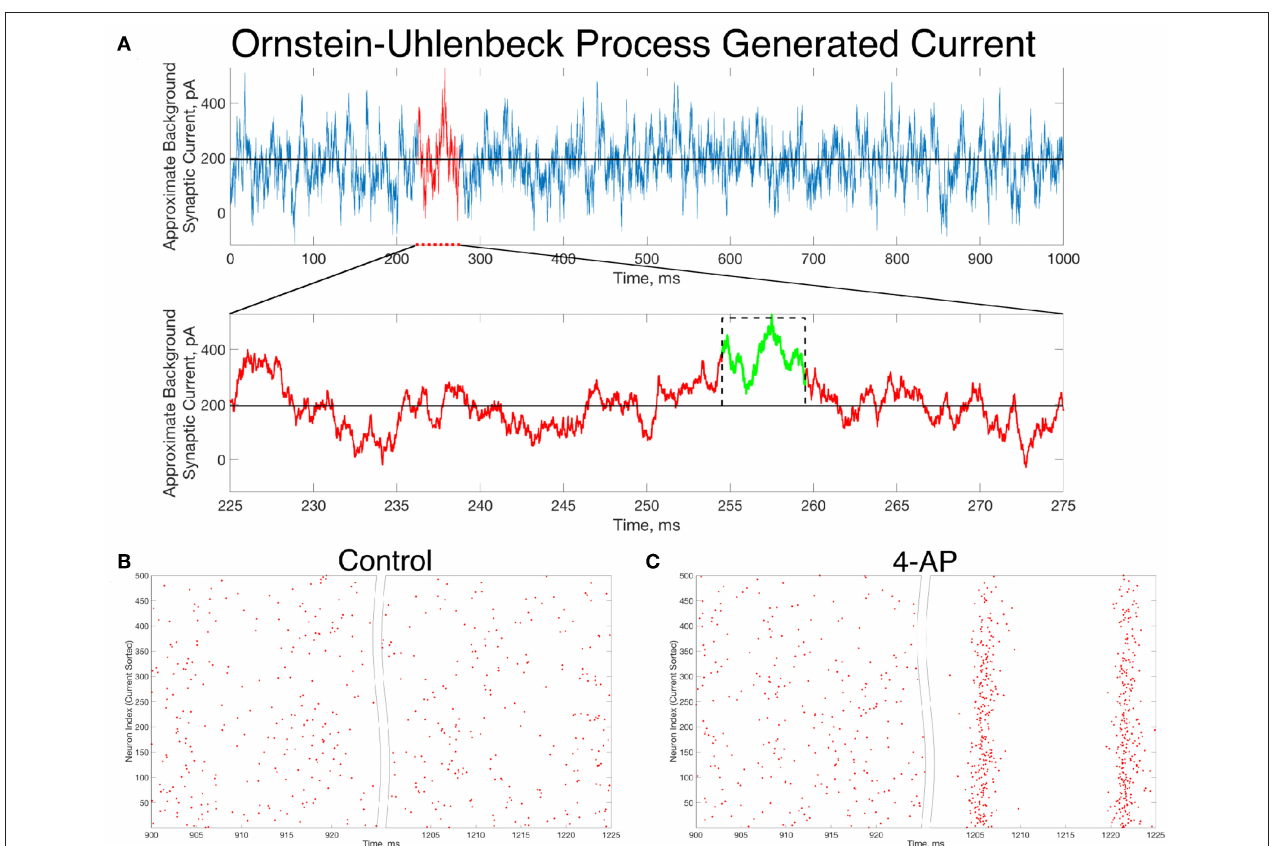
FIGURE 6 | In vivo -like excitatory background synaptic currents can also elicit “bistable transitions” in the model inhibitory networks. (A) An example of excitatory background synaptic current (1,000 ms in the top panel) generated using an Ornstein-Uhlenbeck Process with parameters informed by cortical experimental literature. The bottom panel zooms in on a region of interest (plotted in red) revealing a brief period (plotted in green) in which the current is significantly larger than its average value, activity which has perturbation-like qualities. This activity is approximated by a current pulse of similar width and amplitude, plotted on the figure in a dashed black line. (B,C) Raster plots for a control (B) and 4-AP (C) network that is identical to the examples displayed in Figure 4 , where the large, brief current pulse used as the perturbation throughout this study is replaced by a current pulse informed by the Ornstein-Uhlenbeck Process shown in (A) that represents in vivo -like activity. Despite this change, which amounts to a wider pulse with significantly lower amplitude, the control and 4-AP networks still exhibit antithetical responses to this perturbation; namely, control networks return to asynchronous firing following the perturbation while 4-AP networks transition into synchronous